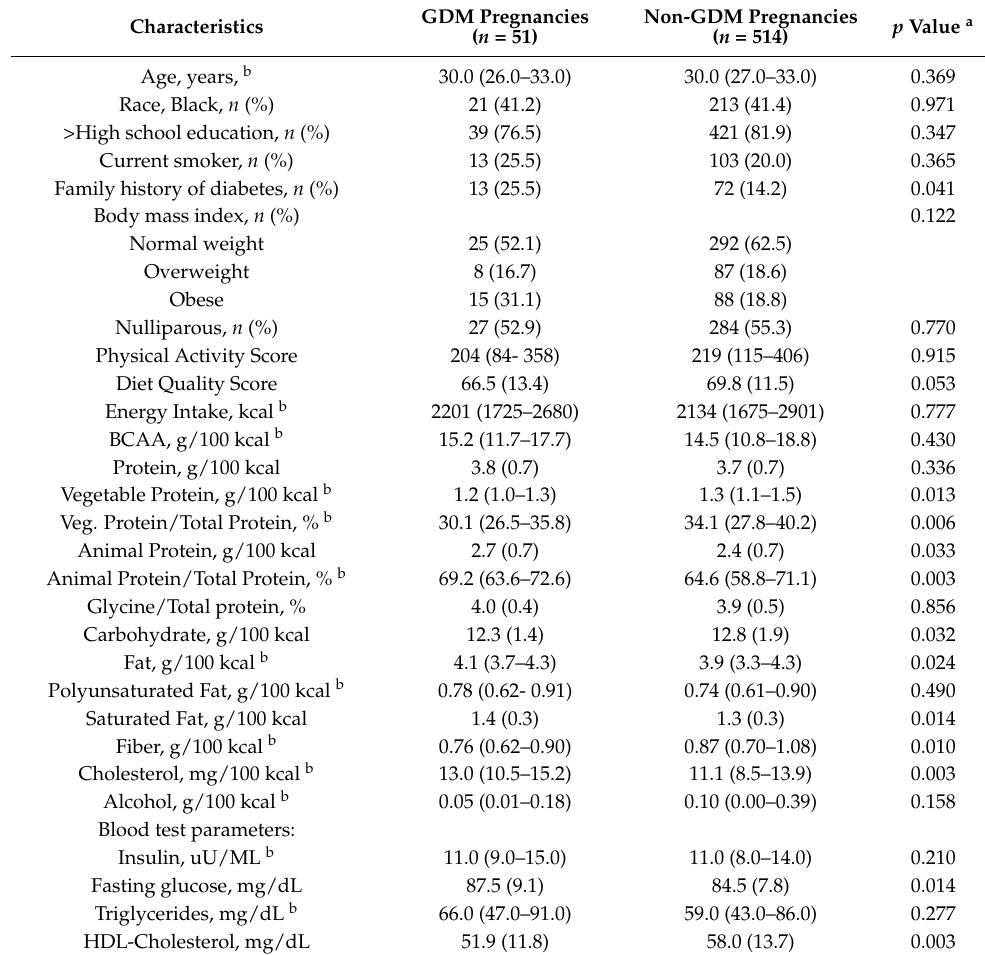
Table 2. Protein Source Subset. Participant characteristics at Year 7 by subsequent GDM pregnancy status, the CARDIA study ( n = 565), 1992–2011.